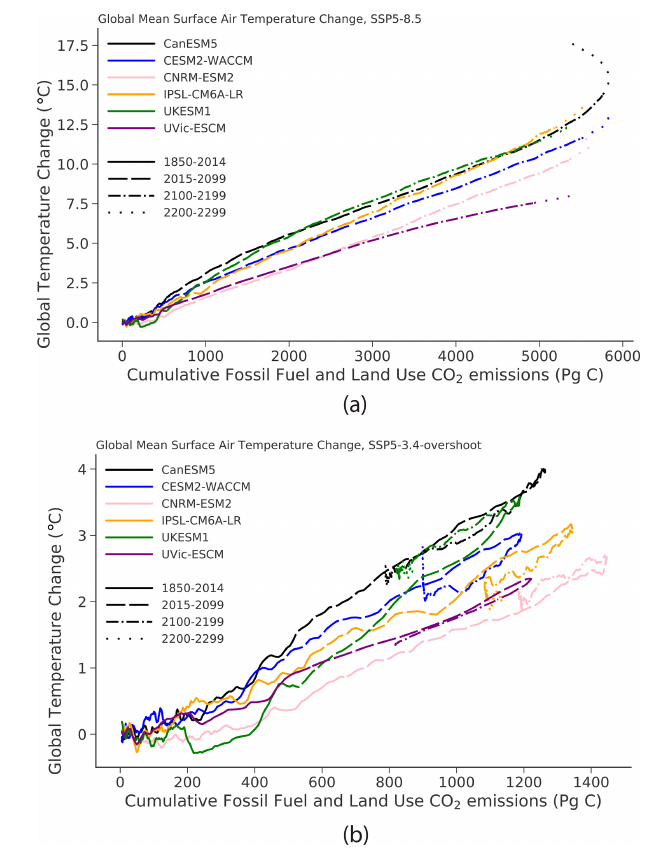
Figure 3. Global warming as a function of cumulative CO 2 emis- sions under the SSP5-8.5 (a) and SSP5-3.4-overshoot (b) scenarios. Emissions here are the sum of fossil fuel fluxes separately inferred for each ESM and land use fluxes taken from the IAM that speci- fied the two scenarios. Each model is identified by a color, and the time periods, broken into roughly centennial periods, are indicated by the dash patterns of the curves: historical (solid), 21st century (dash), 22nd century (dash–dot), 23rd century